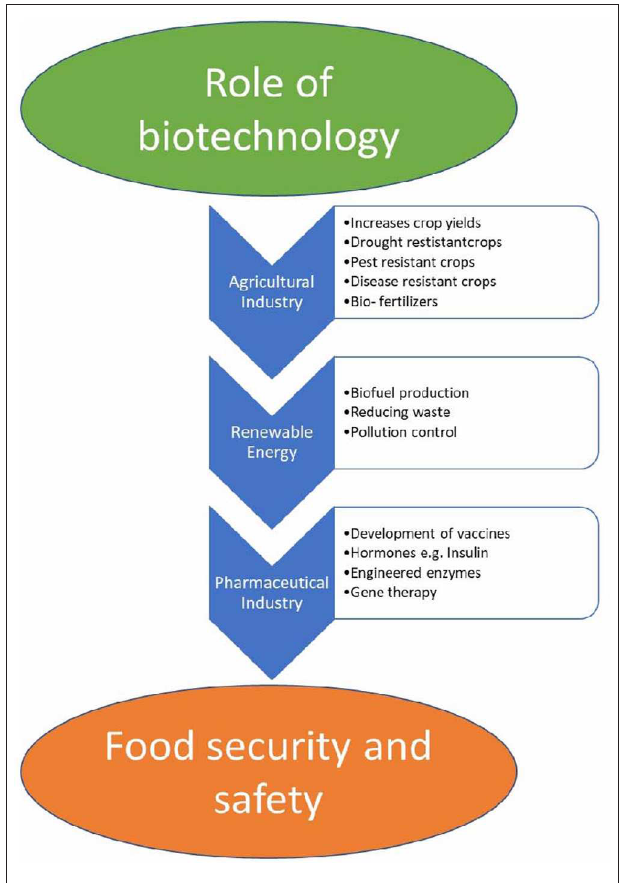
FIGURE 2 | A systematic representation of the influence of biotechnology in food security and